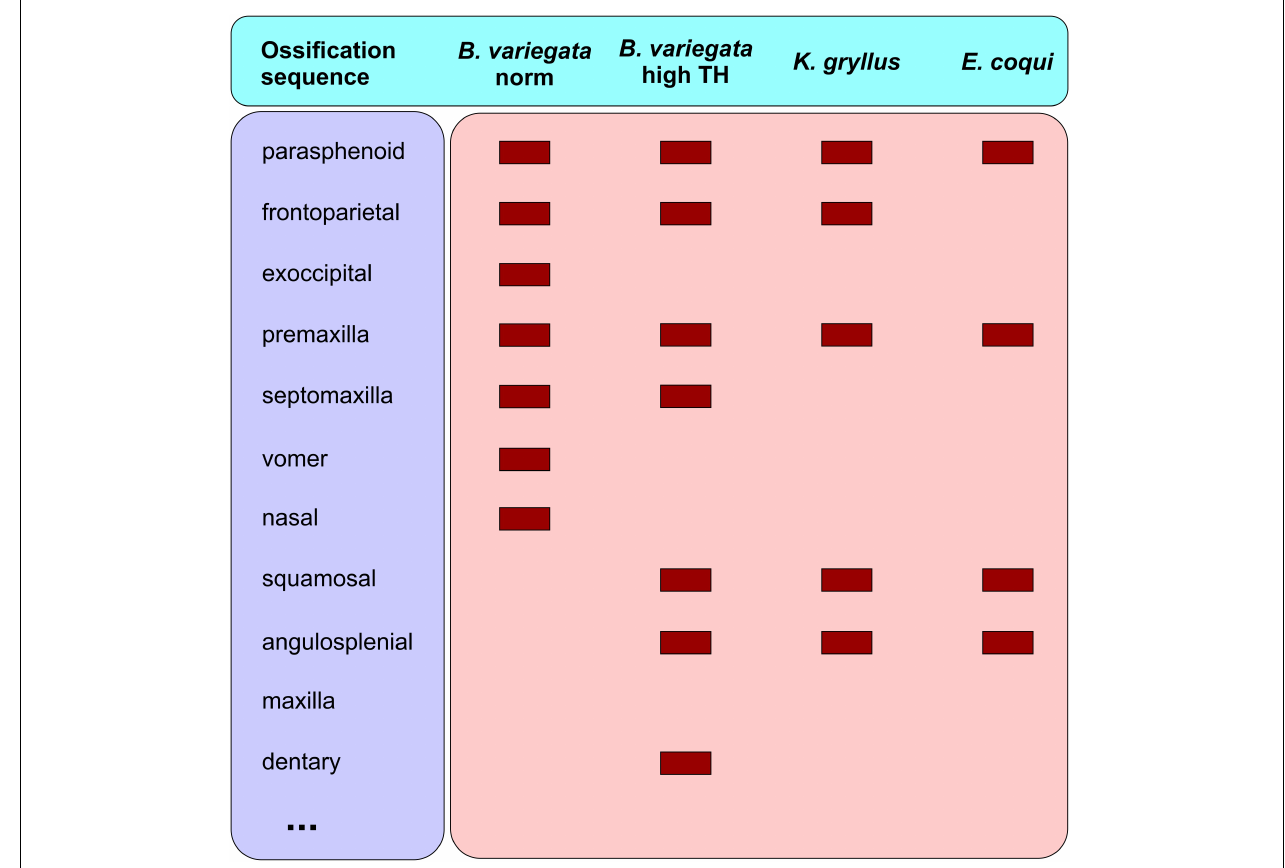
FIGURE 10 | First cranial bones in Bombina variegata (under normal conditions and under high-dosage T 3 -treatment beginning from 6 dph) and in direct developing frogs, Kurixalus gryllus (after Vassilieva, 2017) and Eleutherodactylus coqui (after Hanken et al., 1992).